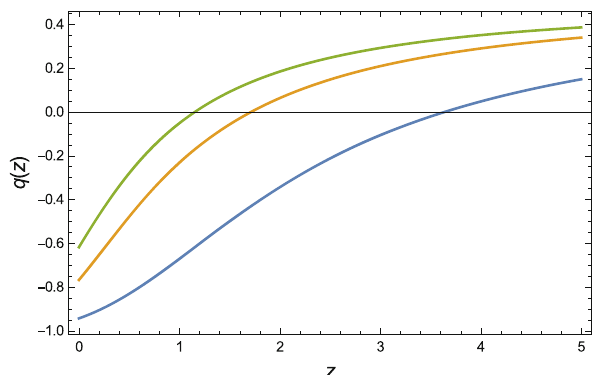
Fig. 2 Evolutionofthedecelerationparameterforconstantjerkparam- eter Eq. (25) with redshift z , for λ = 1 and A = 0 . 2. The blue curve represents a choice of the parameter B = − 0 . 1 while yellow corre- sponds to B = − 0 . 5 and green refers to B = −